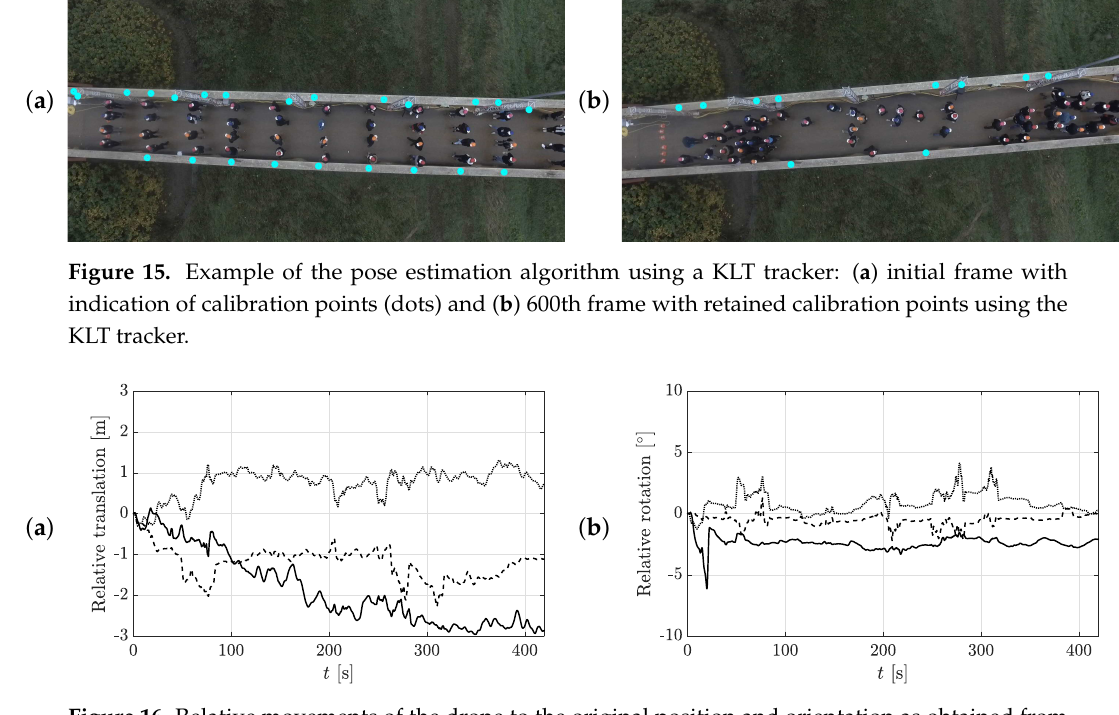
Figure 16. Relative movements of the drone to the original position and orientation as obtained from the position and orientation estimation algorithm: ( a ) translations along and ( b ) rotation around the X (dashed), Y (dotted) and Z (solid)